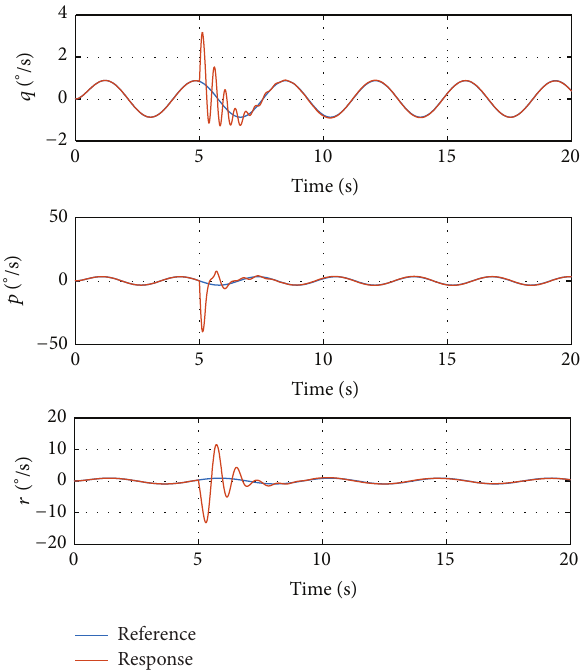
Figure 6: Commands and responses in simulation with sinusoidal input signal.